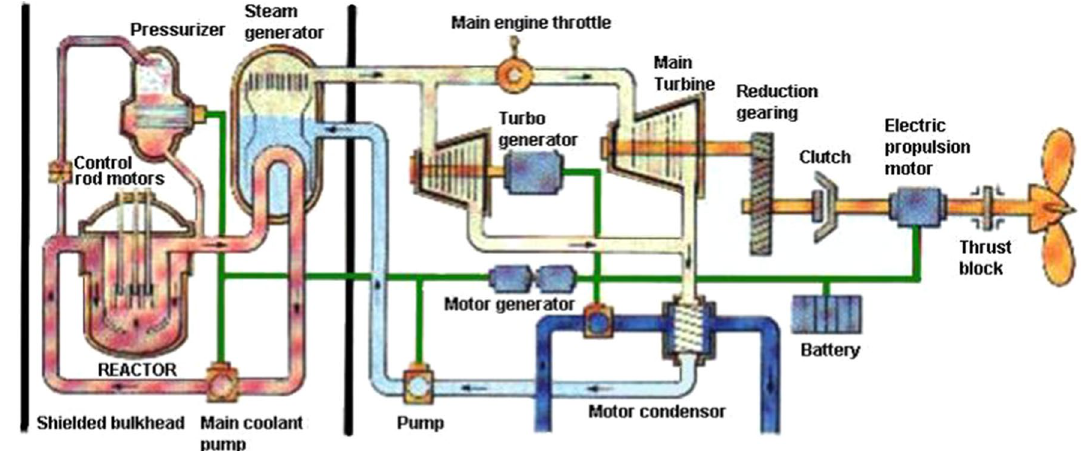
Fig. 11 Nuclear propulsion system (www. man. fas.